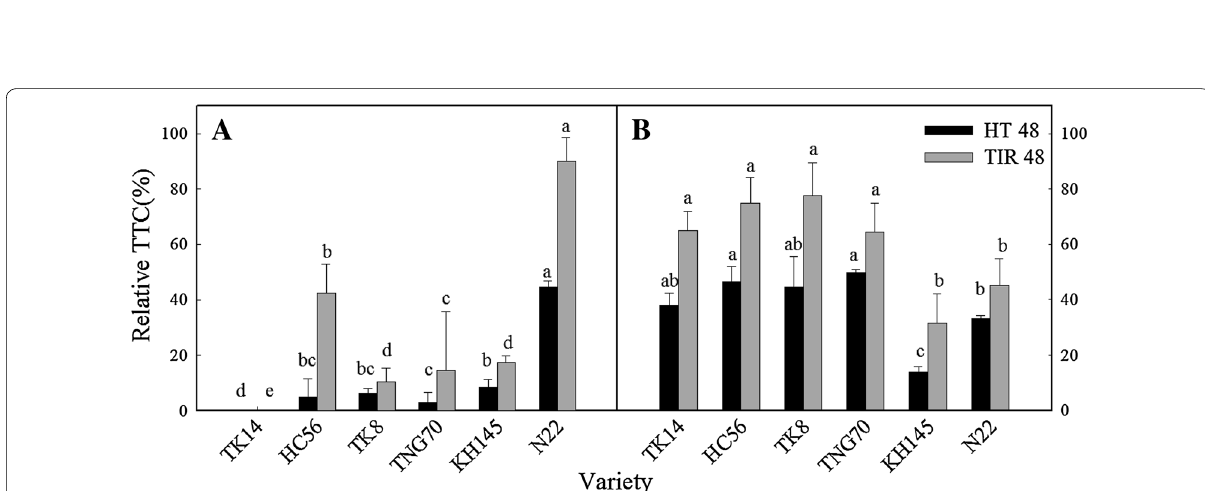
Fig. 10 Relative TTC (%) of the roots ( A ) and shoots ( B ) of rice seedlings grown using the wrapping method under HT48 and TIR48; different letters above the same color bars indicate a significant difference at the 0.05